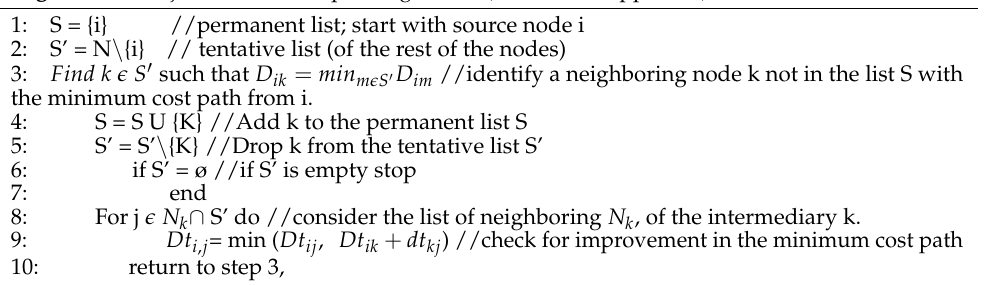
Algorithm 1. Dijkstra’s shortest path algorithm (centralized